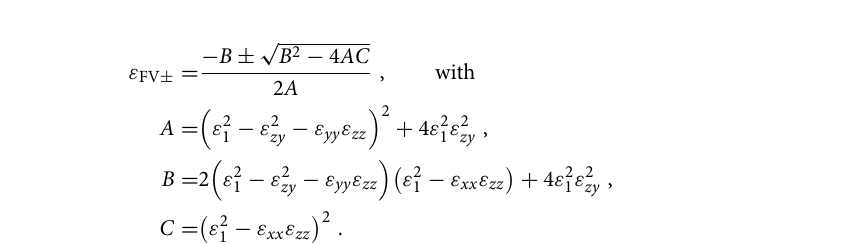
, ( b ) ε FV , ( c ) ε zz , and ( d ) ε xx , with respect to the dimensionless frequency − + 0.5 ω p 1 , and ω c = =